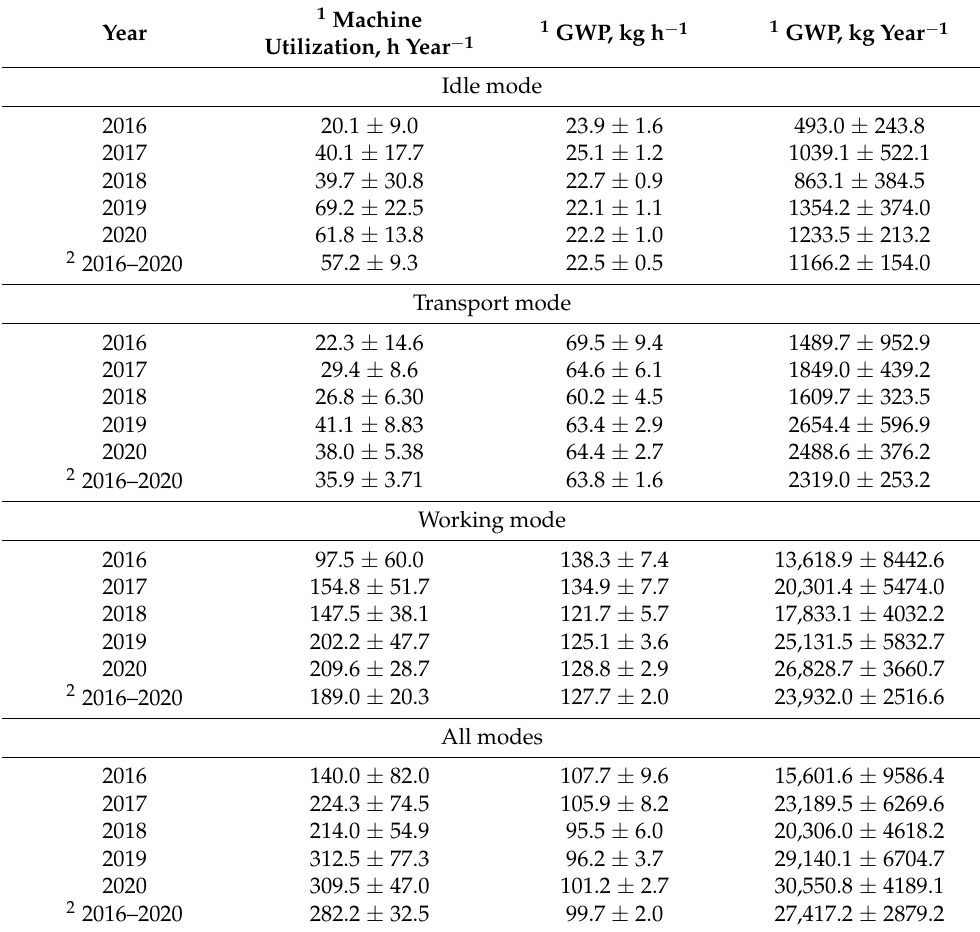
Table 4. Combine harvester operating time structure and global warming potential (GWP) in various engine